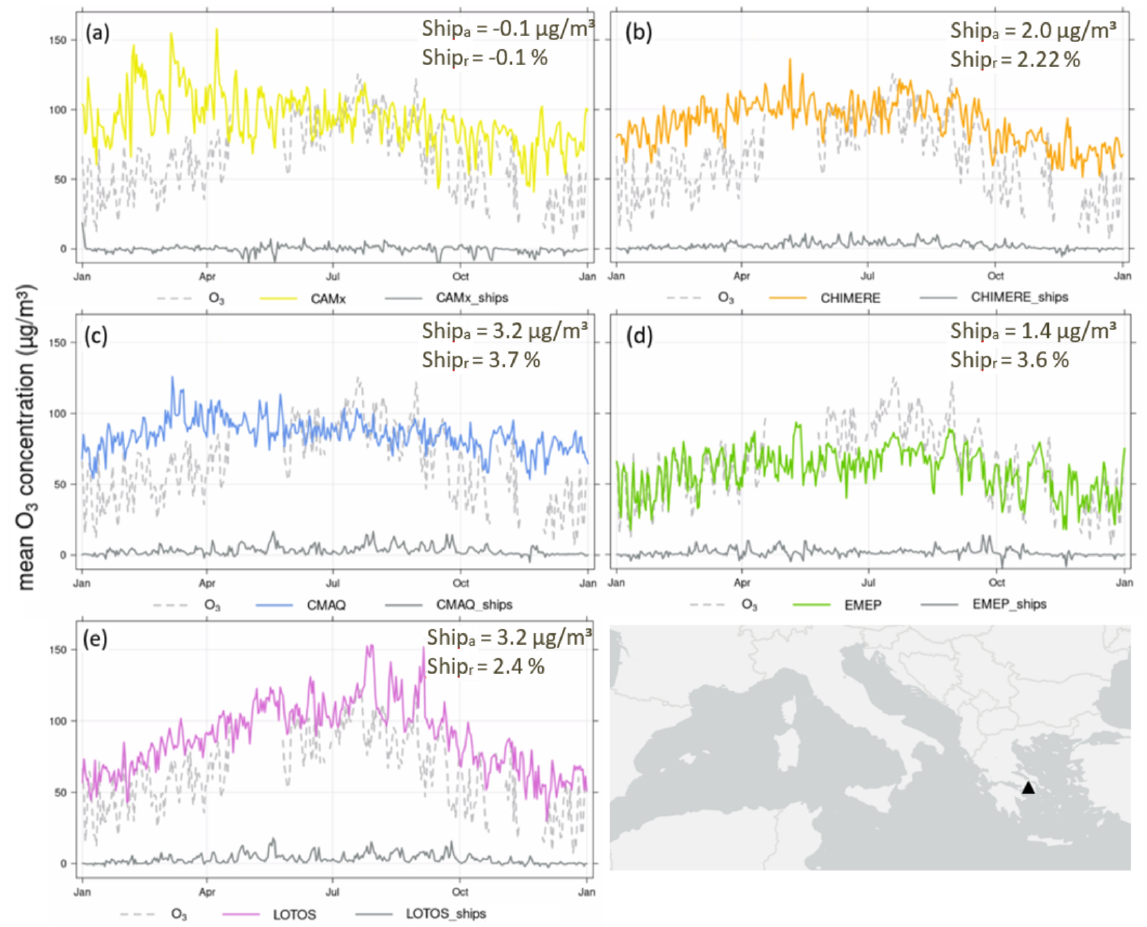
Figure D3. Time series with daily mean O 3 concentration in 2015 at station gr0035a in Greece. The black triangle on the map (bottom right) displays the location of the station. (a) CAMx; (b) CHIMERE; (c) CMAQ; (d) EMEP; (e) LOTOS-EUROS. Dashed gray line – measured data; colored lines – modeled data; gray line – modeled potential ship impact. Correlation between modeled and measured data for hourly total emission data for 2015: CAMx = 0 . 29; CHIMERE = 0 . 46; CMAQ = 0 . 50; EMEP = 0 . 71; LOTOS-EUROS = 0 . 57. Ship a : potential absolute ship impact; Ship r : potential relative ship impact of the respective